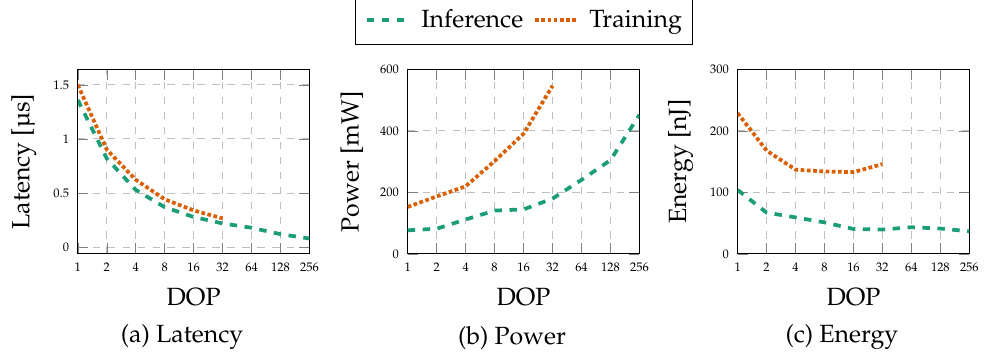
Figure 9. Latency, power and energy on